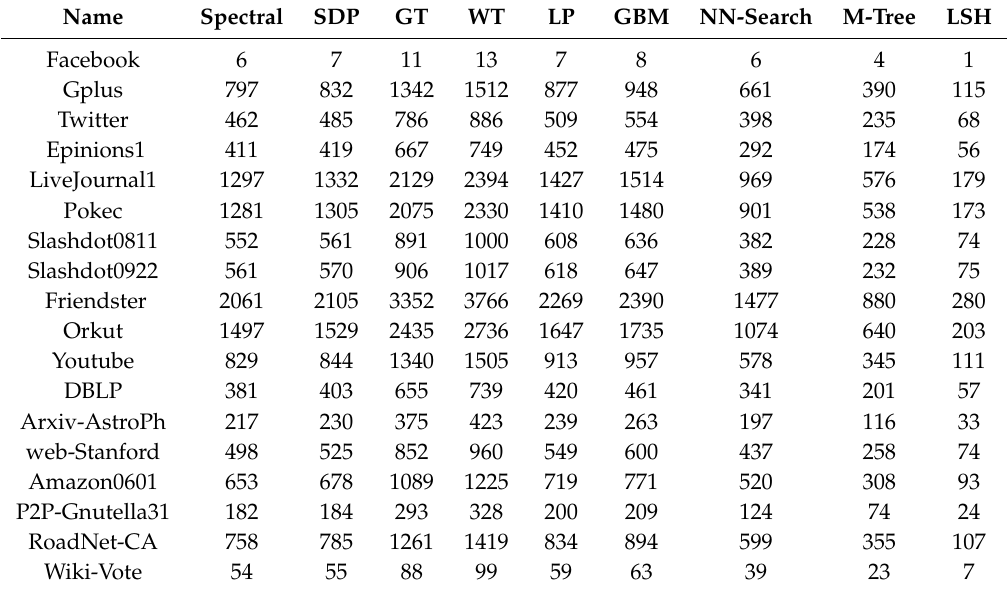
Table 6. Comparison of our approaches with other best methods in terms of